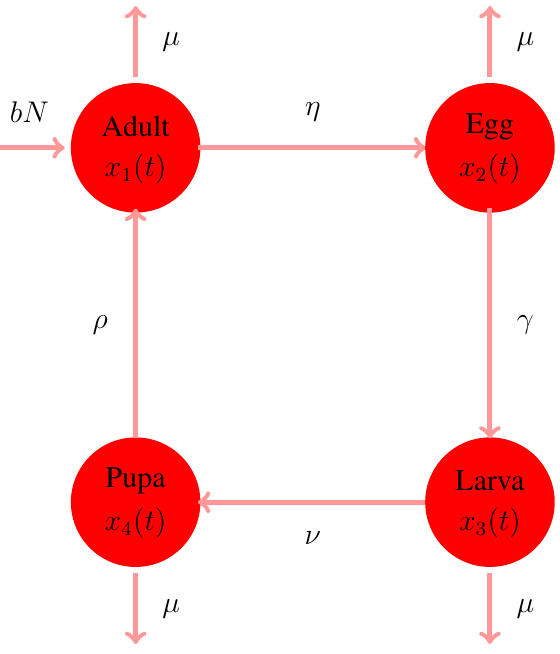
Figure 1: A flow chart of the life cycle of a